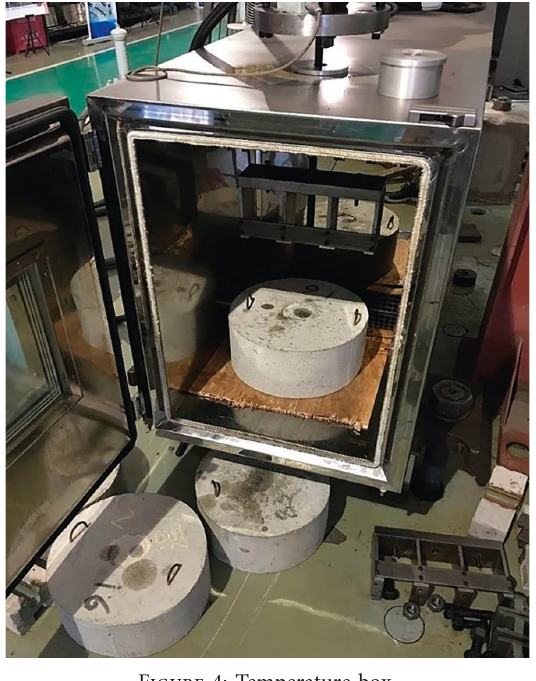
Figure 4: Temperature box.